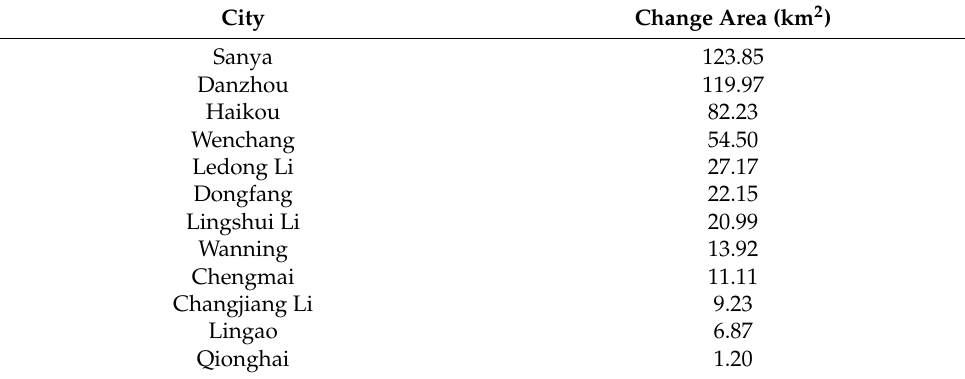
Figure 9. Variable zone example: the change area between the pre-founding simulated coastline and the modern simulated coastline; Sanya and Haikou are enlarged and displayed. Table 4. The coastline change area of each city in Hainan Island.